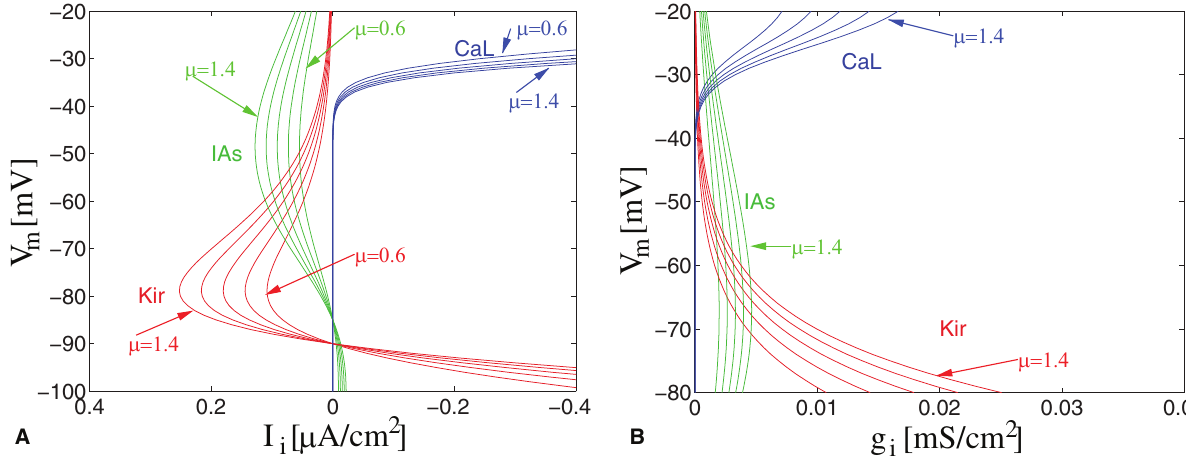
Figure 1. Modulation of ion channel density. Variable factors ( µ = {0.6 ... 1.4}) for the slowly inactivating K + -channel (Kv1.2, I As ), the L-type calcium channel ( I CaL ), and the inward rectifying K + channel ( I Kir ) are shown at different membrane voltages V modulation in